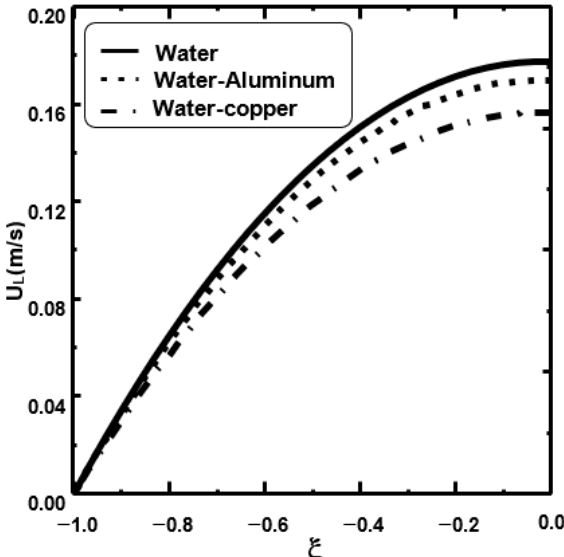
Figure 6. Effect of nanoparticles type on the liquid velocity at the exit channel: T 0 = 20 ◦ C, T 0L = 20 ◦ C, q 1 = 3000 W/m 2 , T w = 20 ◦ C, c 0 = 0, u 0 = 1 m/s, m 0L = 15 × 10 − 4 Kg/m · s, p 0 = 1 atm, d/H = 0.015, φ 0 = 0.05.